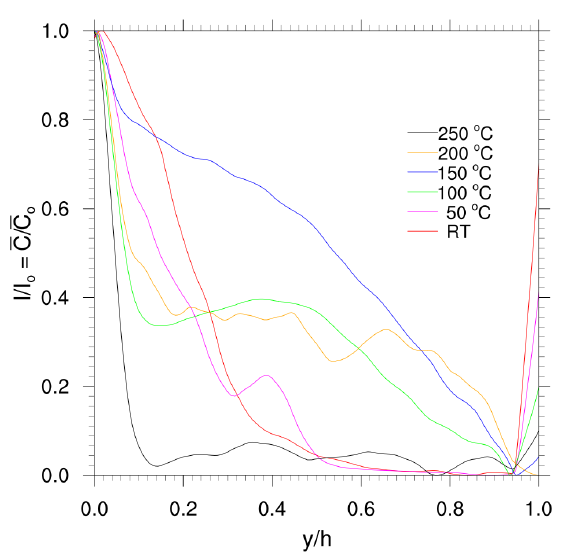
Figure 4. Normalized SIMS profiles of sodium in the molybdenum thin films for different sub- strate temperatures. y / h = 0 is the Mo/SLG interface location, and y / h = 1 is the accumulation layer